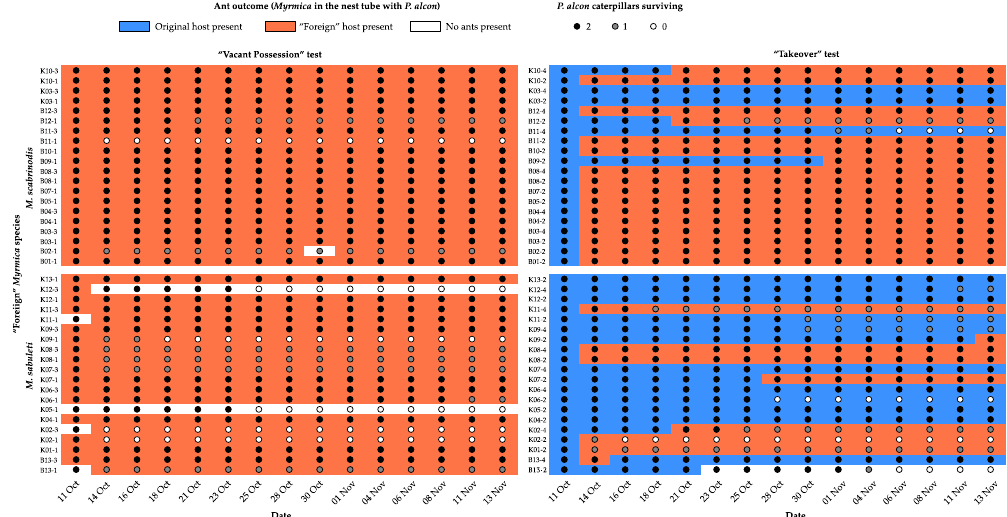
Figure 3. Time course of the two experiments showing which ant species occupied the tube containing the P. alcon caterpillars, and how many of the original 2 caterpillars were still alive at each